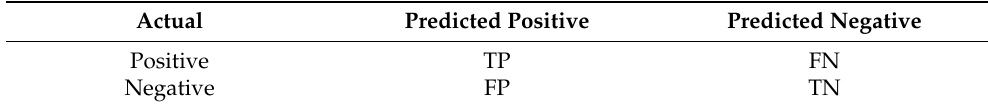
Table 2. Confusion matrix of the